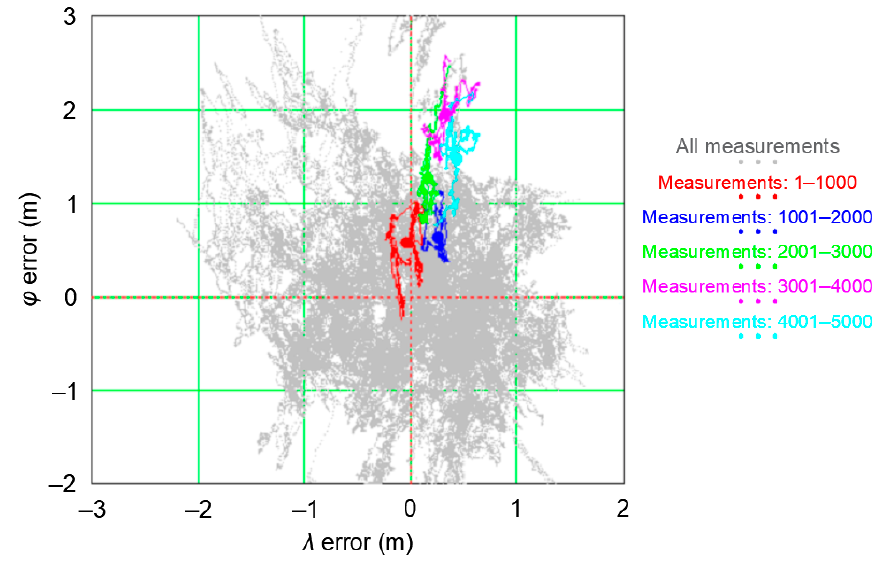
Figure 7. GPS position error distribution during the measurement campaign in 2013.